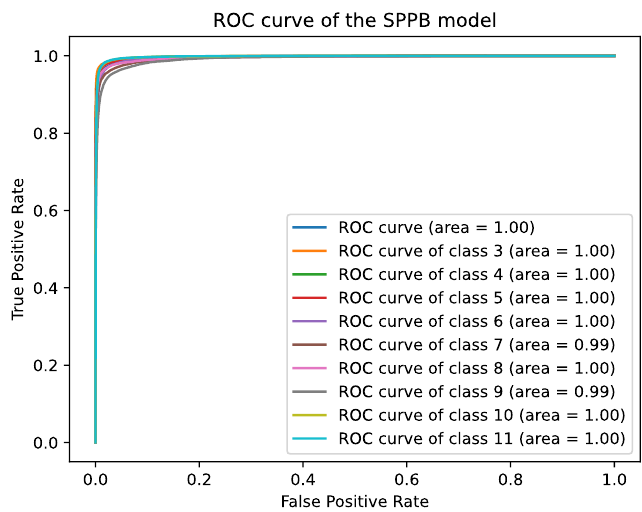
% at epoch 67. Figure 3. The ROC curve of the TUG model. Figure 7. The ROC curve of the TUG model. Figure 8. The ROC curve of the SPPB model.